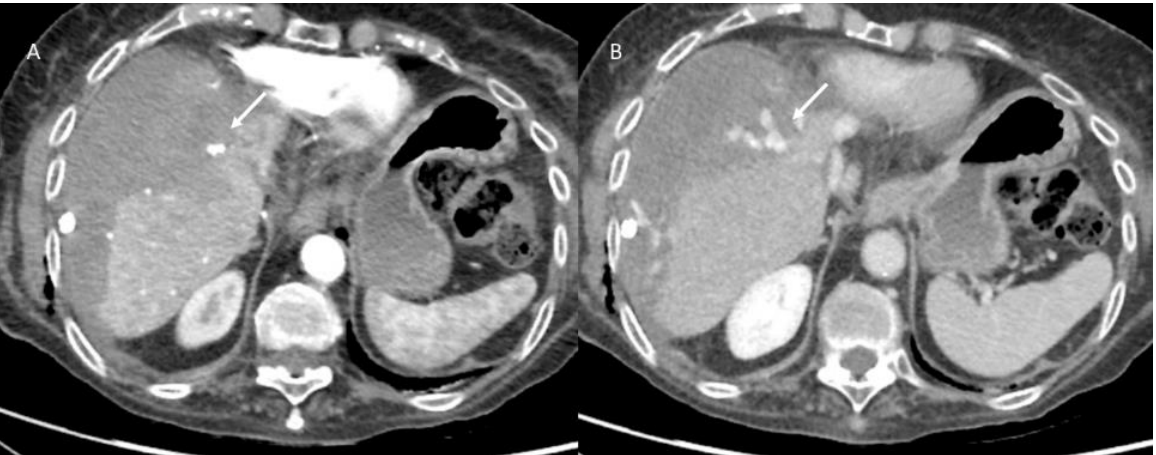
Figure 6. Active bleeding. During arterial CT assessment ( A ) and portal evaluation ( B ), arrow shows active overflow of contrast